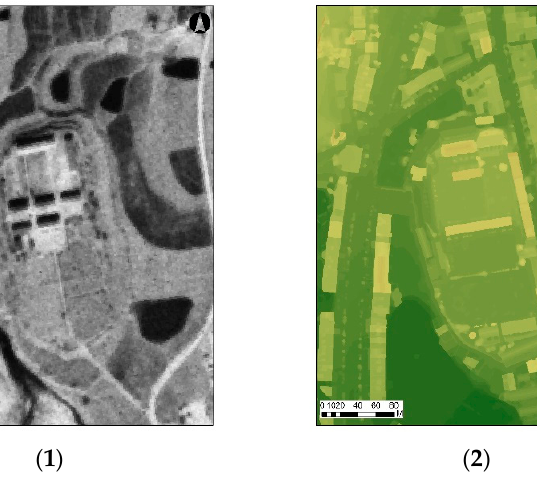
Figure 2. Remote sensing images of the Lvwangcheng site (( 1 ) is the CORONA satellite image taken in 1968, ( 2 ) is the DSM of lvwangcheng, ( 3 ) is the DOM of Lvwangcheng. The red dotted line in ( 3 ) shows the scope of the city wall).